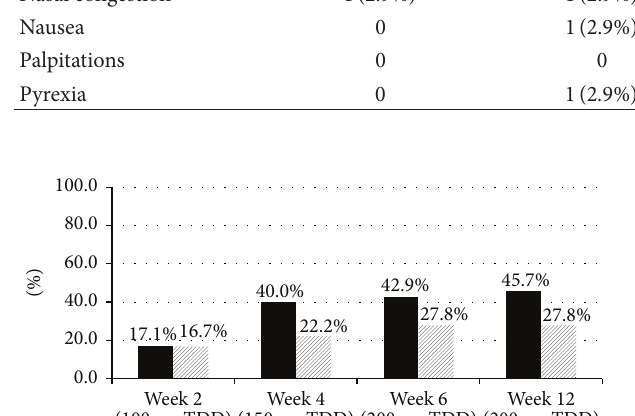
all visits except for week 12 placebo. In both the ITT and the PP population, patients in the 5-ALA-SFC treatment group showed a steady gradual decline in HbA1c over 12 weeks while the placebo group showed an initial decrease in HbA1c but then showed rebound after 6 weeks. At week 12, the mean HbA1c in the 5-ALA-SFC group decreased by − 0.8%, compared to − 0.5% in the placebo group in the PP population (Figure 3(b)). Mean and change from baseline for fasting plasma glu- cose and glucose 2 hours after breakfast are presented in Table 6. Excluding glucose values from the 8 patient visits impacted by Ramadan in the study analysis resulted in no appreciable change in results; therefore, overall mean values including all assessments are presented. There was a decrease in serum glucose and glucose 2 hours after breakfast from baseline over time observed in both